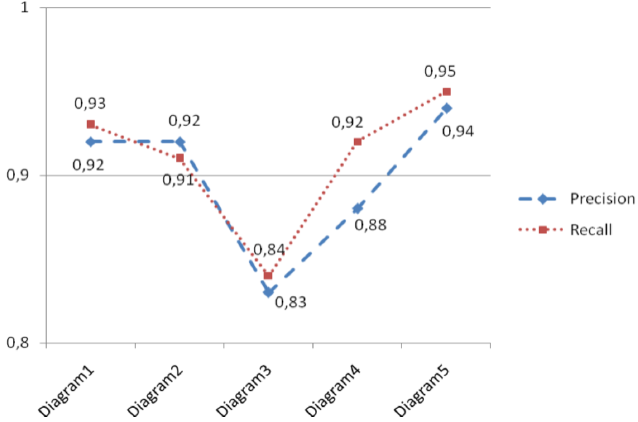
Figure 12. Precision and recall by diagram.